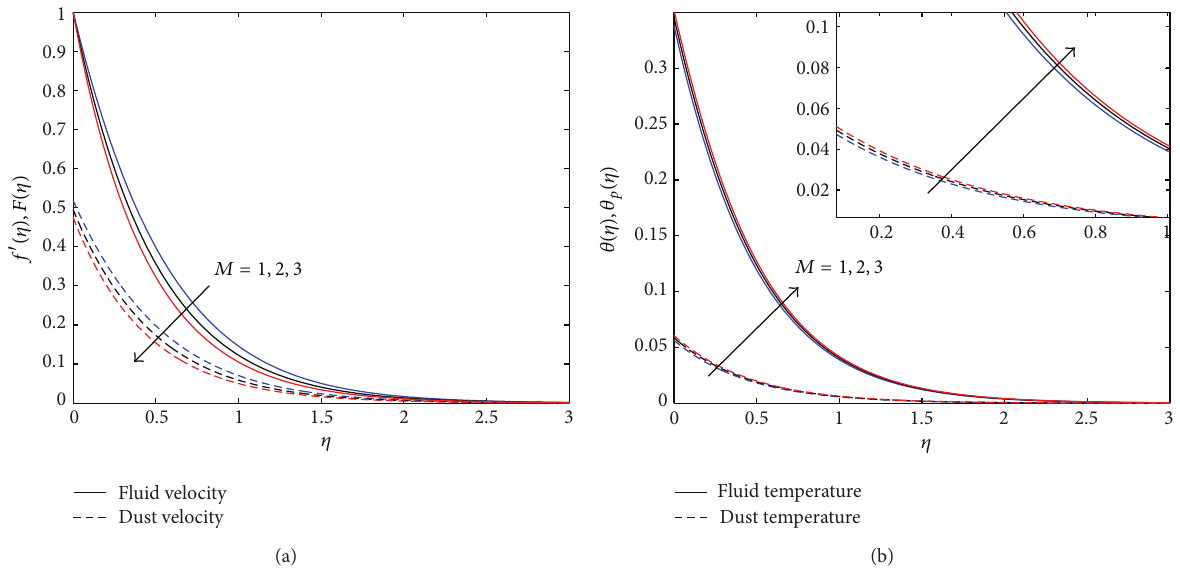
Figure 2: Effect of 𝑀 on (a) 𝑓 󸀠 , 𝐹 and (b) 𝜃 , 𝜃 𝑝 when 𝑆 = 2 , 𝛽 ℎ = 1 , 𝑁 = 1 , Bi = 1 , and Ec = 0.1 .